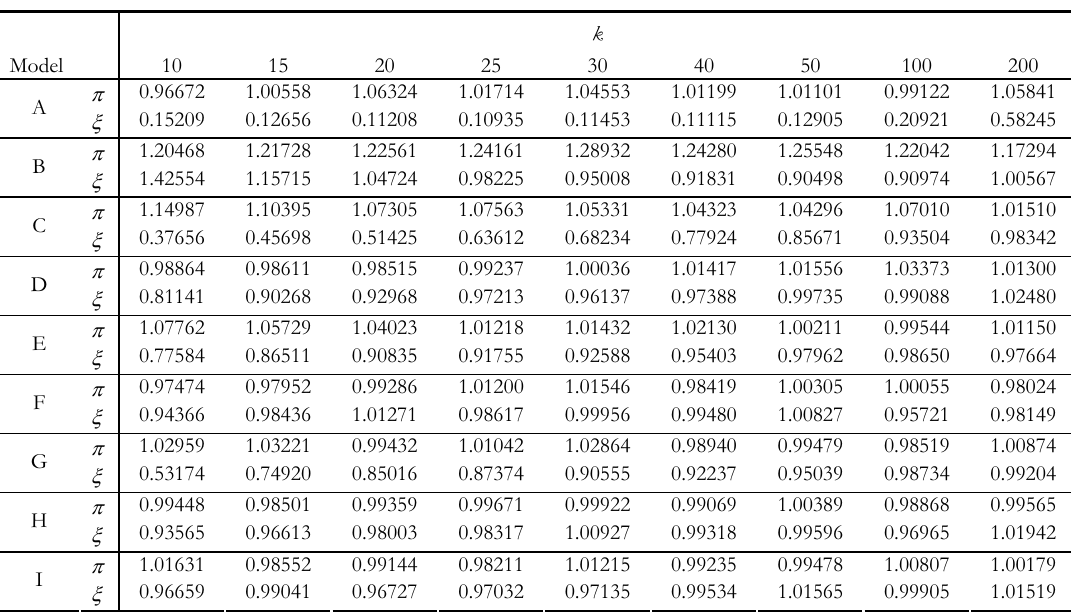
Relative efficiency of the ML estimators for (cid:83) and (cid:91) (m=7)